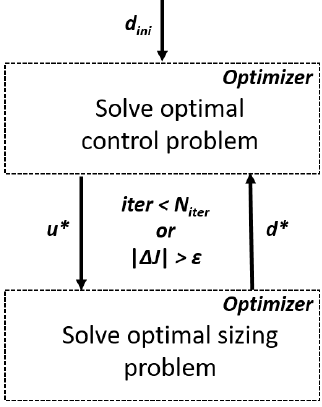
Figure 6. Iterative